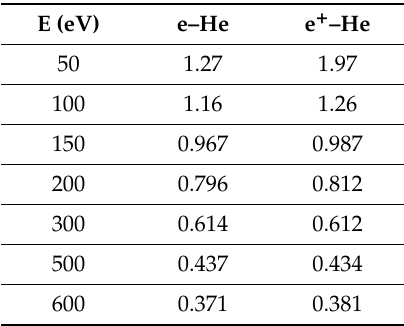
) for e–He and e + 0